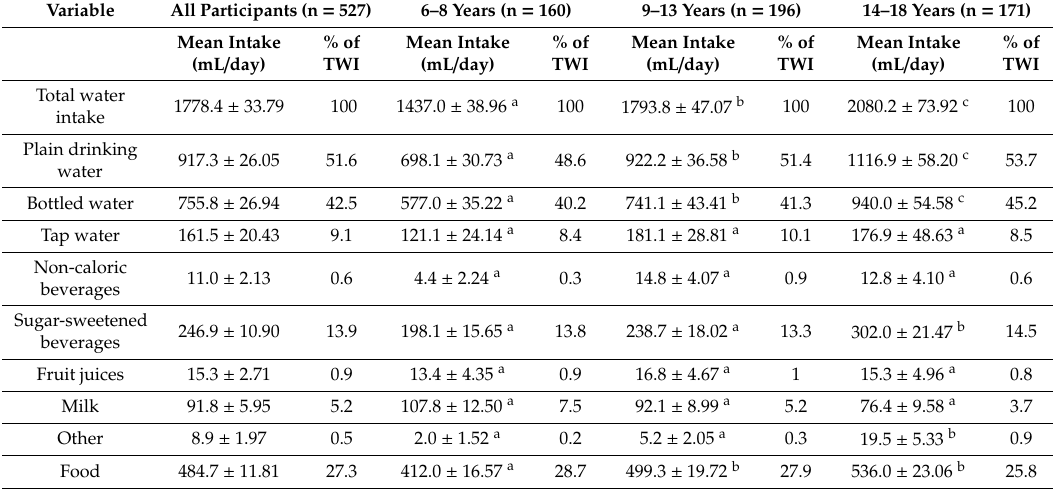
Table 3. Mean water intake by source and by age